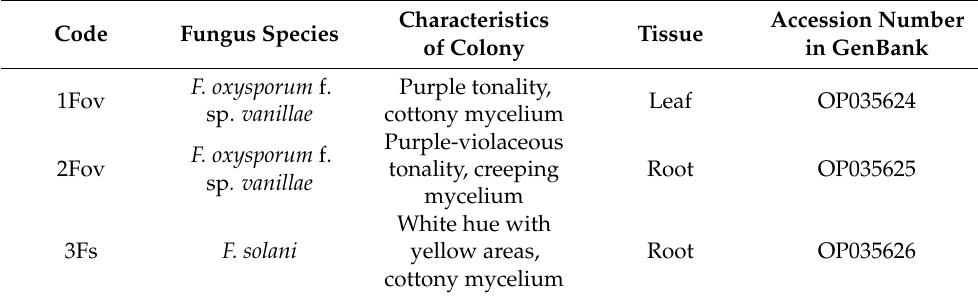
Table 1. Fusarium isolates were used to evaluate the development of Fusarium wilt in vanilla accessions in